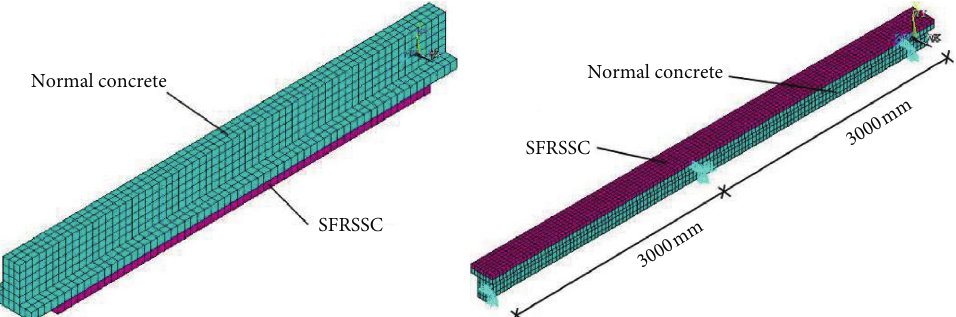
Figure 24: Models of test beams.